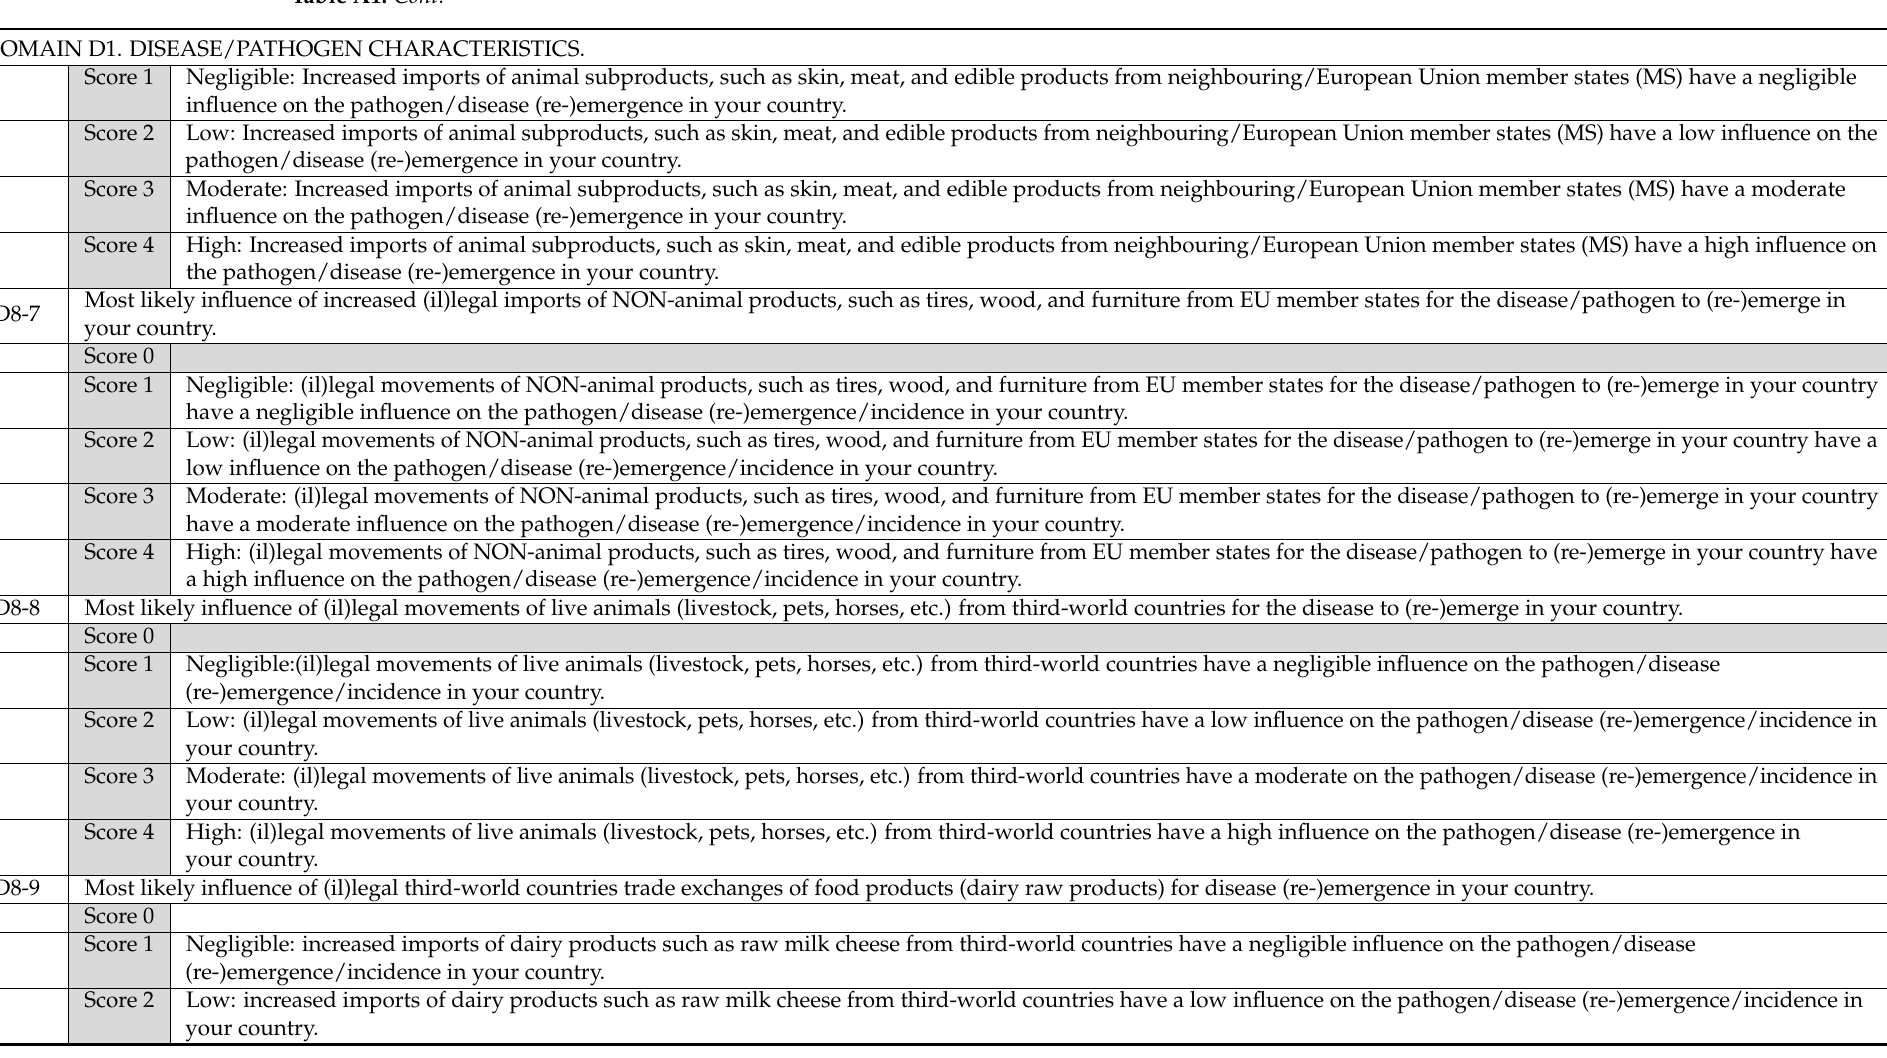
DOMAIN D1. DISEASE/PATHOGEN